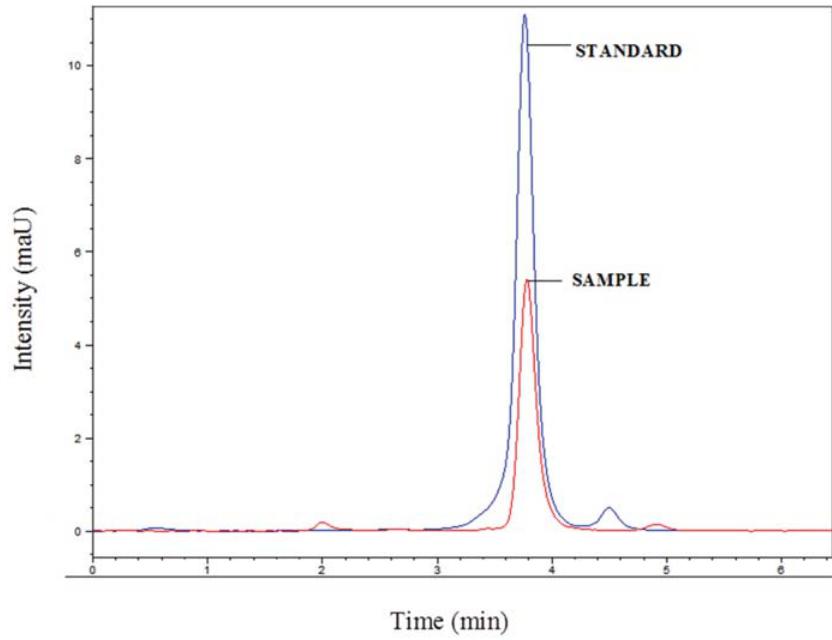
Figure 1. HPLC-FLD chromatograms of AFM1 standard (100 ng/mL) and naturally contaminated milk sample no. 14